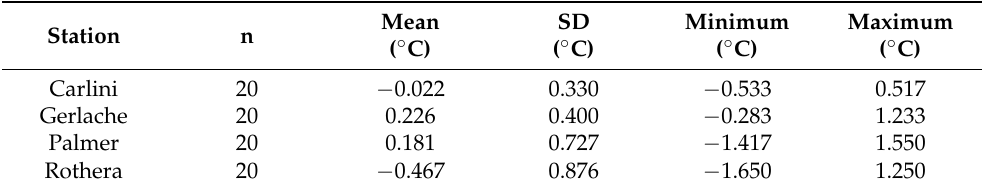
Figure 2. Time series of January SST (°C) at ( a ) Carlini, ( b ) Gerlache, ( c ) Palmer, and ( d ) Rothera sites. Table 1. Descriptive statistics of the time series (2001–2020) of January SST (°C) at four locations in the West Antarctic Peninsula (WAP).